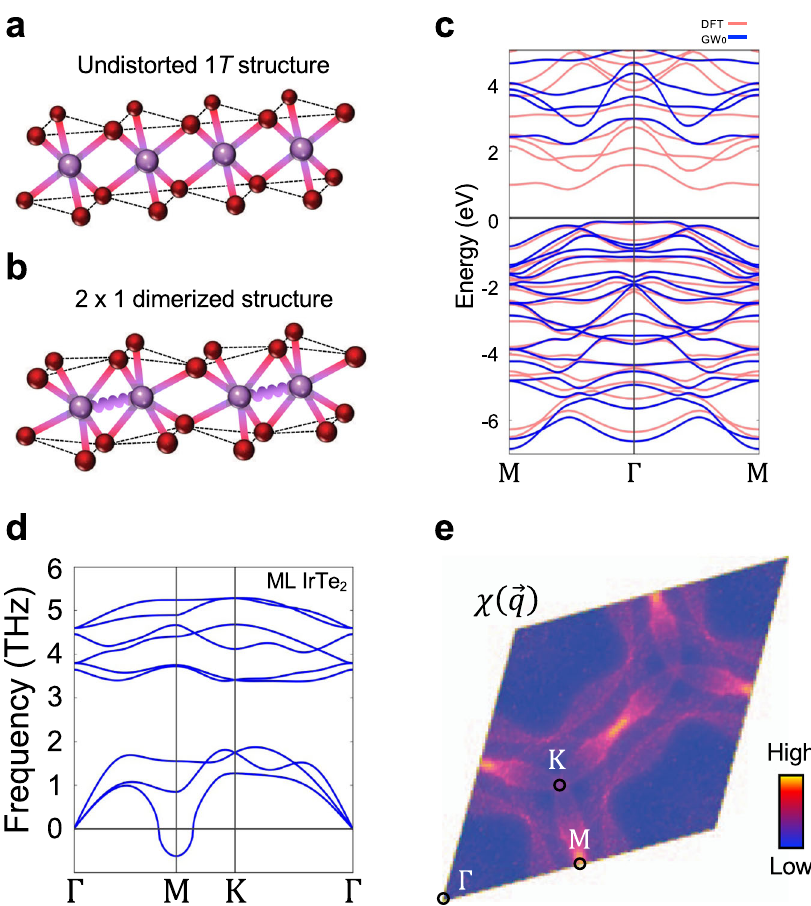
Fig. 4 Origin of the large-gap 2 × 1 dimerized structure. a , b Schematics of the crystal structure of a ML undistorted 1 T -IrTe 2 and b 2 × 1 Ir dimerized ML IrTe 2 . Purple wavy line represents a Ir dimerization. c Comparison between calculated DFT (pink) and GW 0 (blue) band structures. d Calculated phonon spectrum of ML 1 T -IrTe 2 along its high symmetry directions. e Real part of the electronic susceptibility χ ~ q ð Þ of ML 1 T -IrTe 2